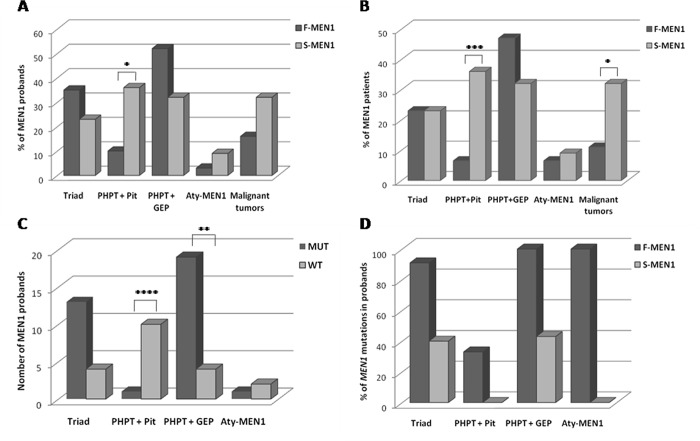
MEN1 manifestations in the groups of F-MEN1, S-MEN1 probands and MEN1 mutation-negative and mutation-positive probands.(A) Association of the main MEN1-related tumors and tumor aggressiveness in probands with F-MEN1 and S-MEN1 syndrome. (B) Association of the main MEN1-related tumors and tumor aggressiveness in patients of the whole cohort with F-MEN1 and S-MEN1 syndrome. (C) Association of the main MEN1-related tumors in MEN1 mutation-positive and mutation-negative probands. (D) Detection rate of MEN1 gene mutations within each main clinical presentation in MEN1 mutation-positive probands with and without family history. Aty-MEN1 refers to atypical MEN1. Statistical significance was determined by Fisher or Chi-square test. *P<0.05, **P<0.01, ***P<0.001, ****P<0.0001.